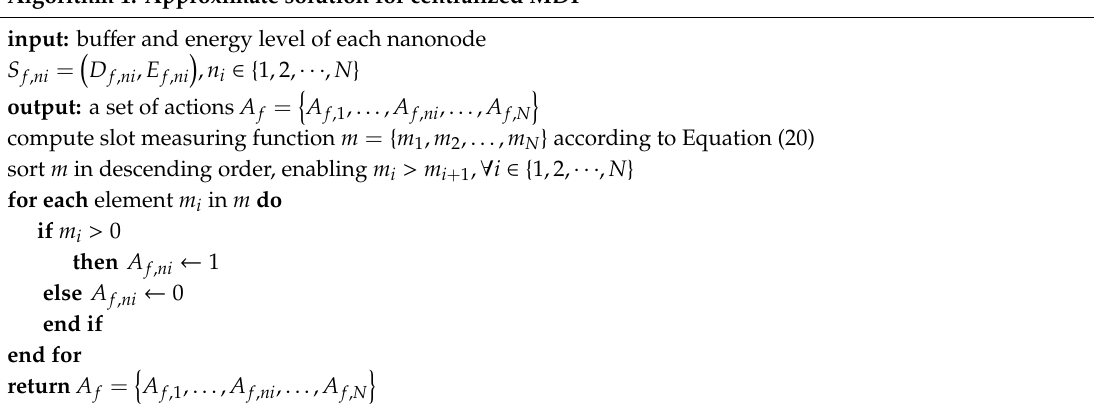
Algorithm 1: Approximate solution for centralized